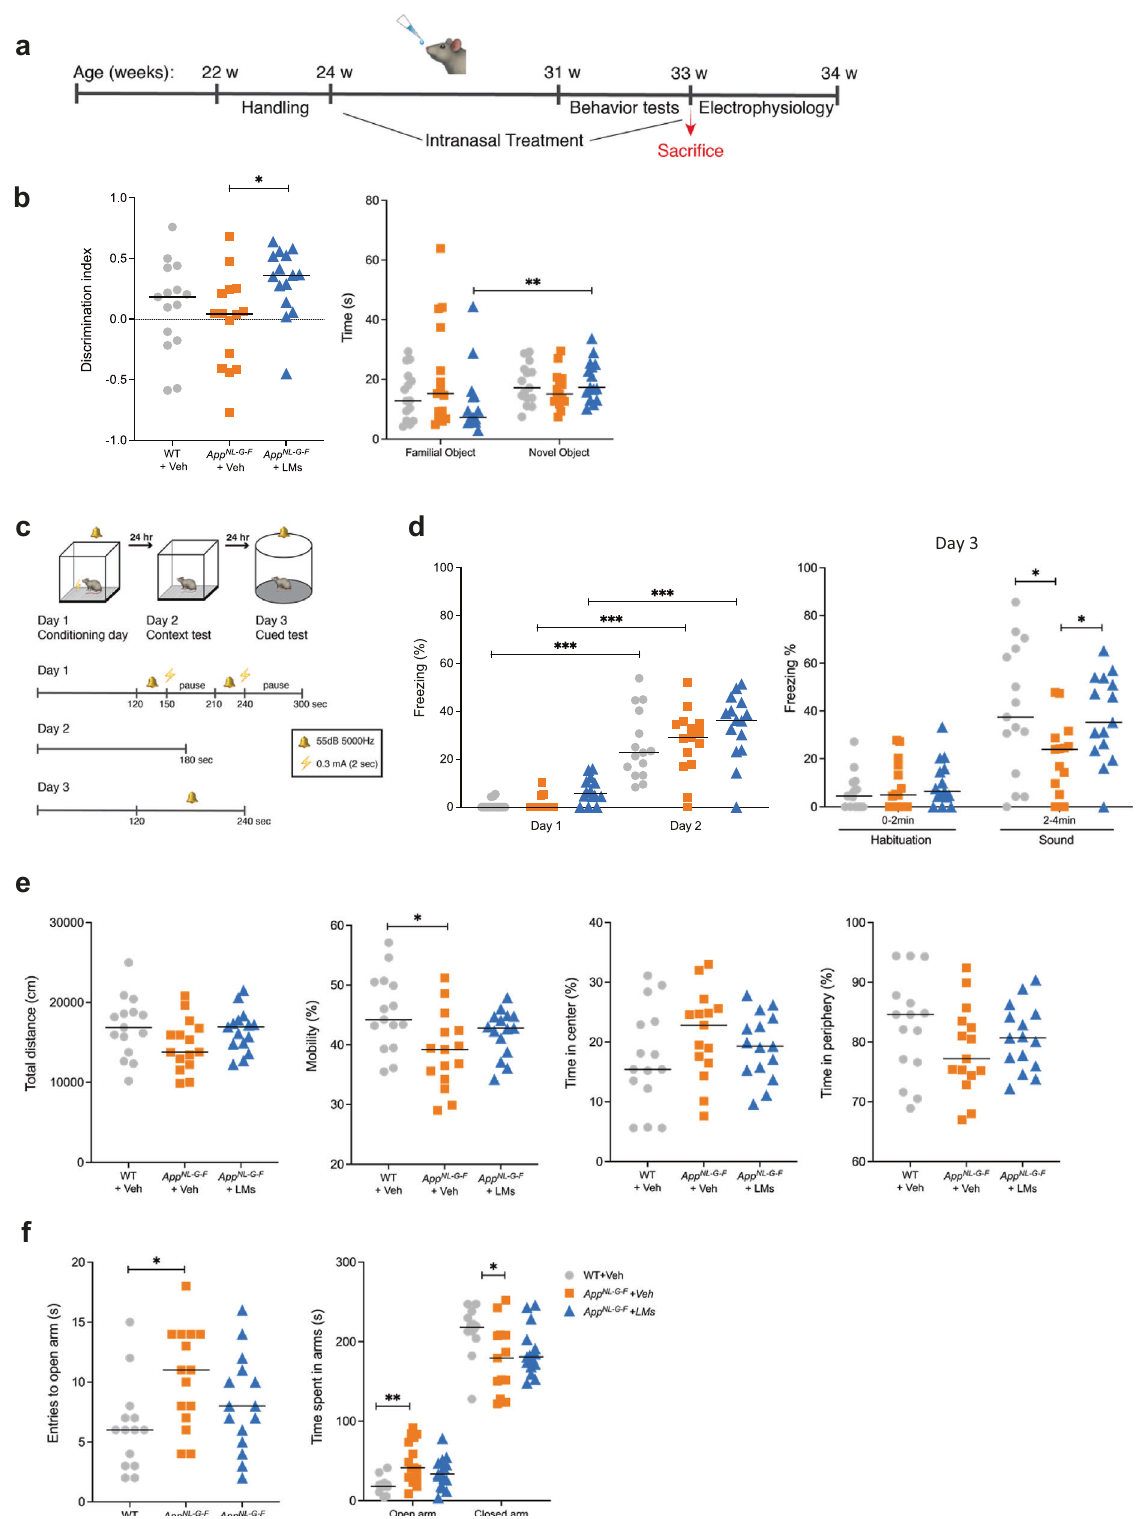
In the EPM test, the App NL-G-F -Veh mice spent longer time in the open arms and made an increased number of entries into the open arms compared to WT mice, indicating reduced anxiety-like behaviour (Fig. 1f). The App NL-G-F mice that were treated with LMs spent the same time in both the open and closed arm as the WT mice. Similar results were obtained by analysis of the time passing before the fi rst visit to the closed arms (Fig. 1f).